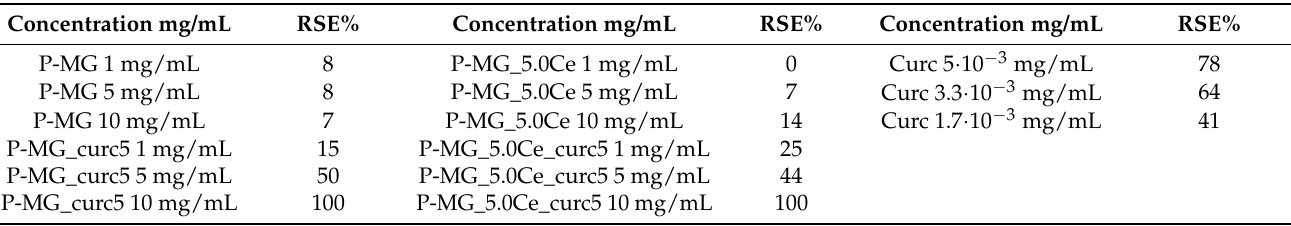
Table 5. Radical scavenging effect of some samples tested to evaluate the antioxidant power against the radical DPPH.